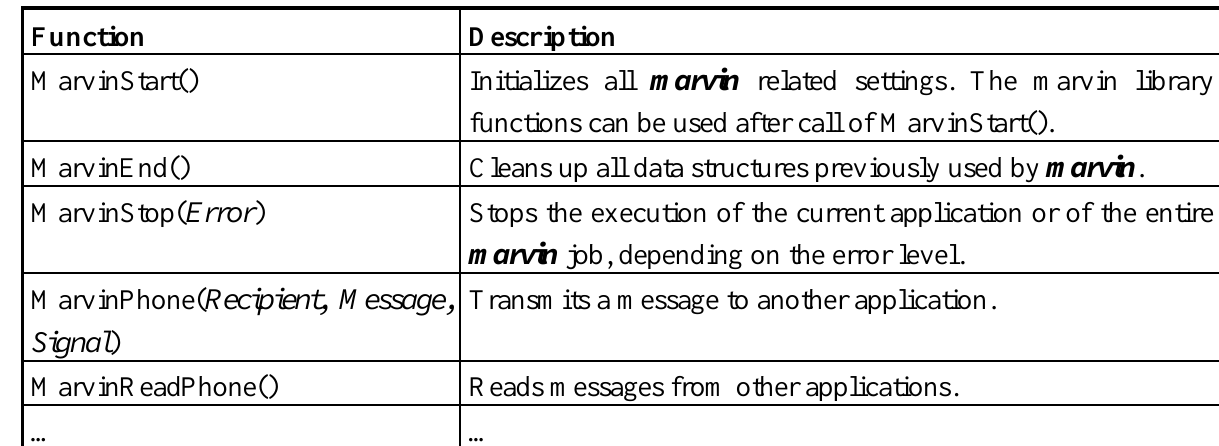
Table 5: marvin runtime library: Example functions for marvin system management.